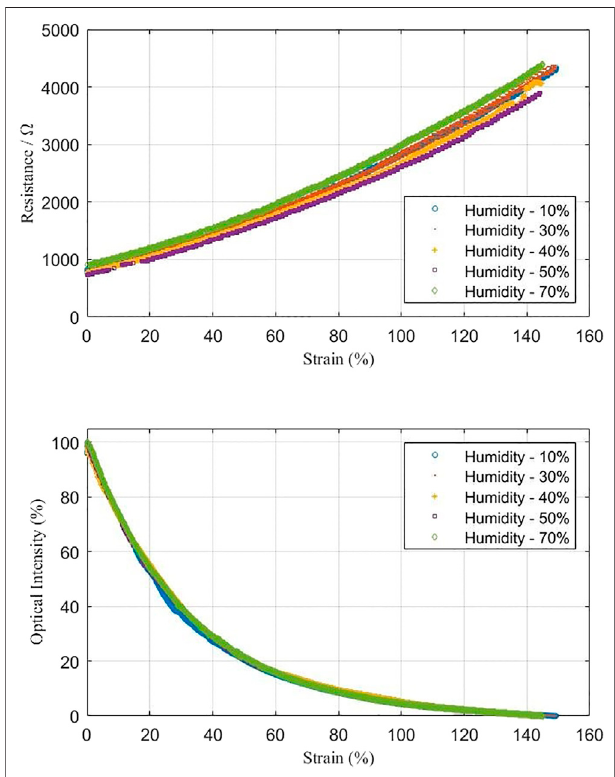
FIGURE 9 | Stretching tests under different humidity situations, from 10 to 70% ambient humidity.